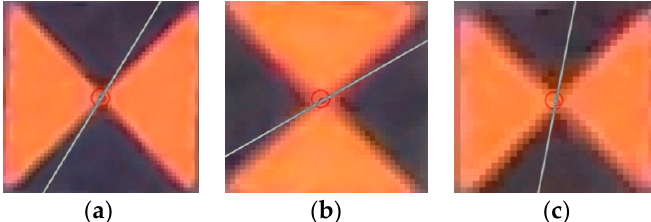
Figure 12. Screen shots with a GCP image in “3DF Zephyr Pro” software (No. 229) positioned approximatively in the calibration field center ( a ) 23 m height, ( b ) 28 m and ( c ) 35 m height.